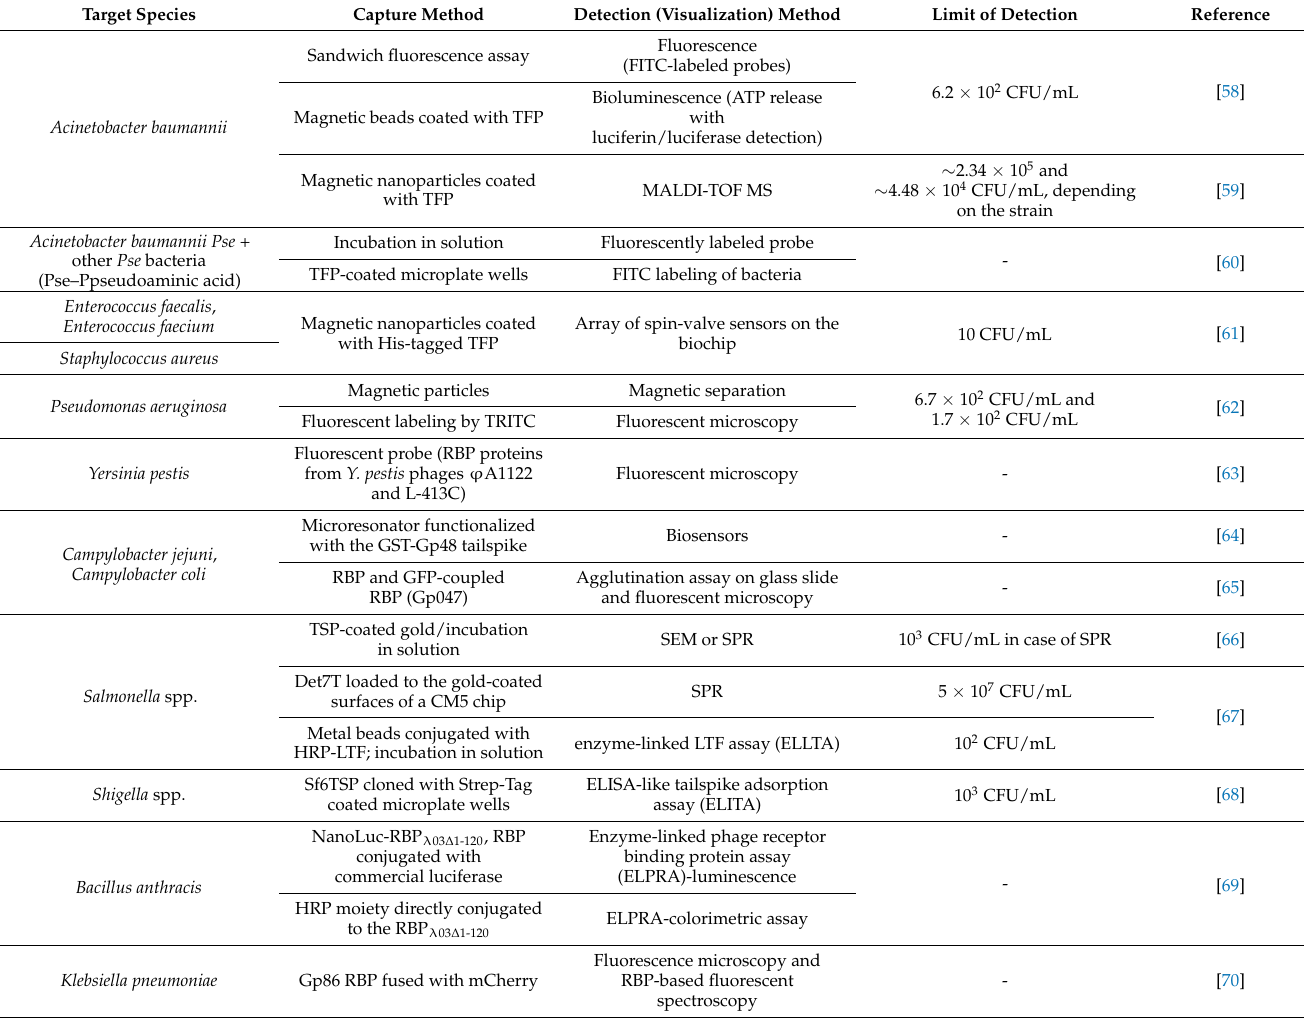
Table 1. Overview of methods based on RBP or TFP from different